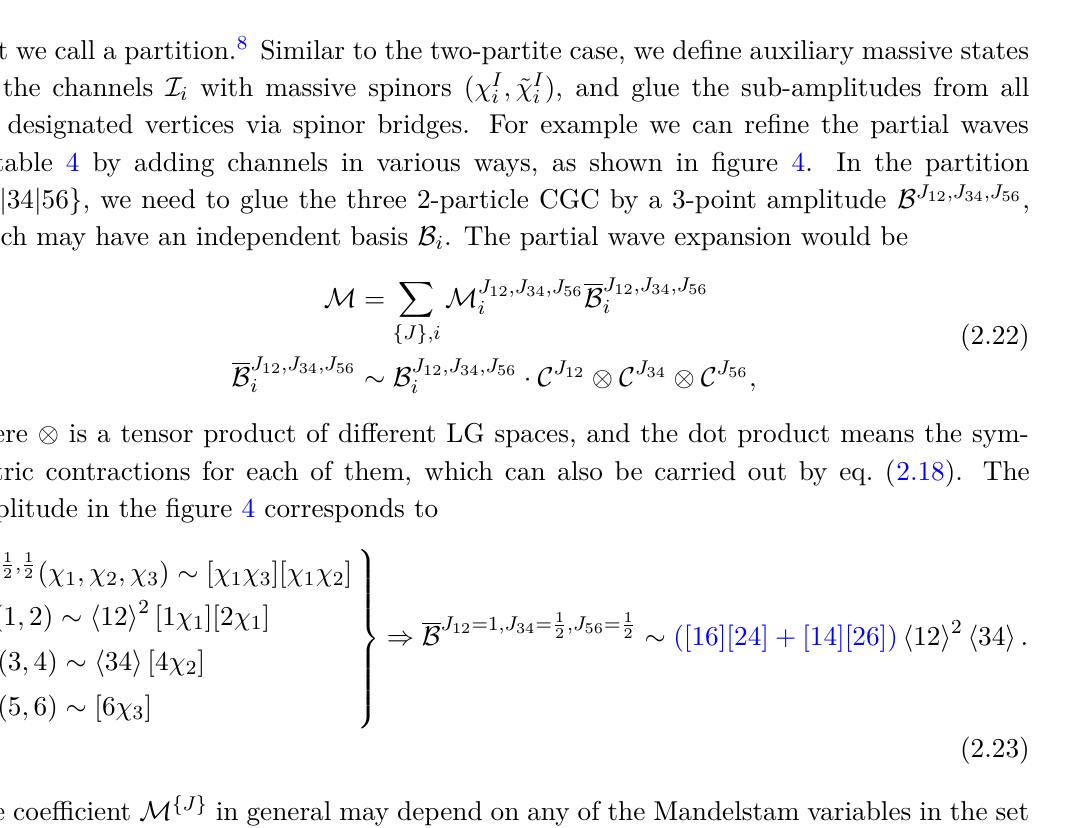
Figure 3 . Topology of a M + N -particle scattering amplitude splitting into 2 and 3 partitions and